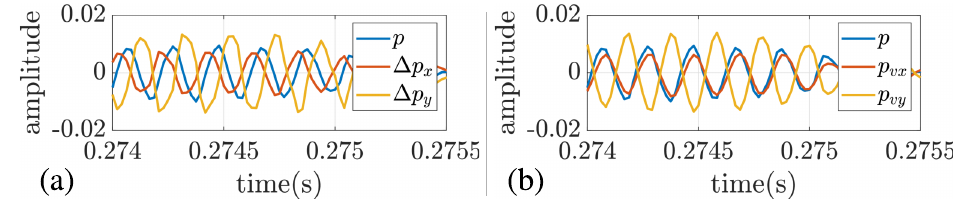
Figure 3. Received time series at station 3: pressure and pressure-difference channels ( a ); pressure and estimated pressure-equivalent particle velocity components ( b ).